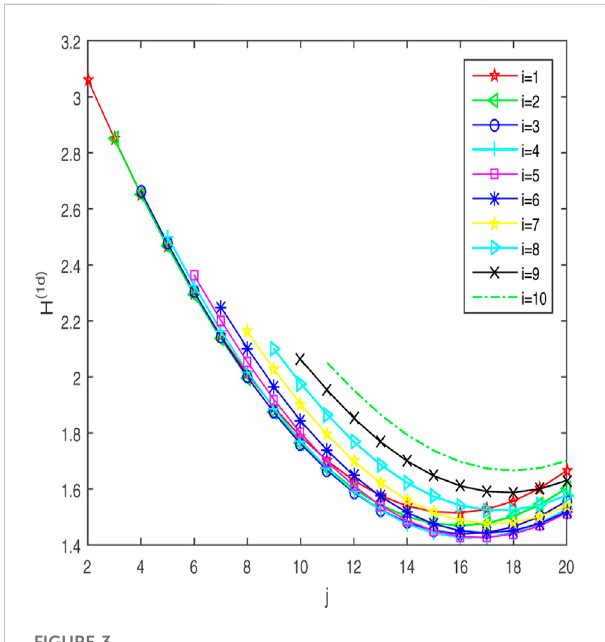
The relationship among the coherence of G d and the edge connection position i,j.